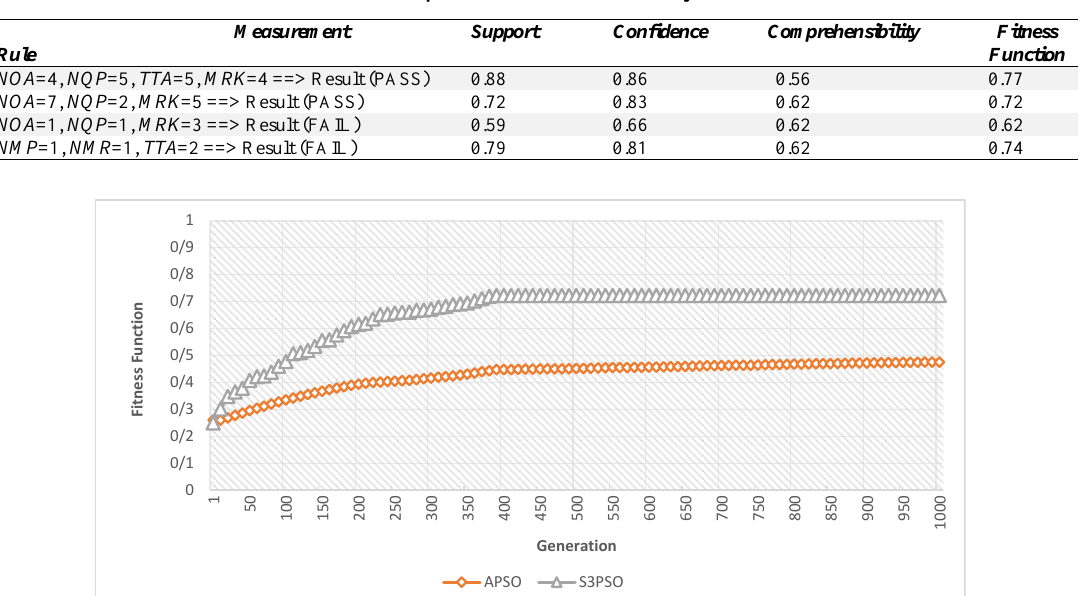
Table 7. Examples of the rules obtained by S3PSO.